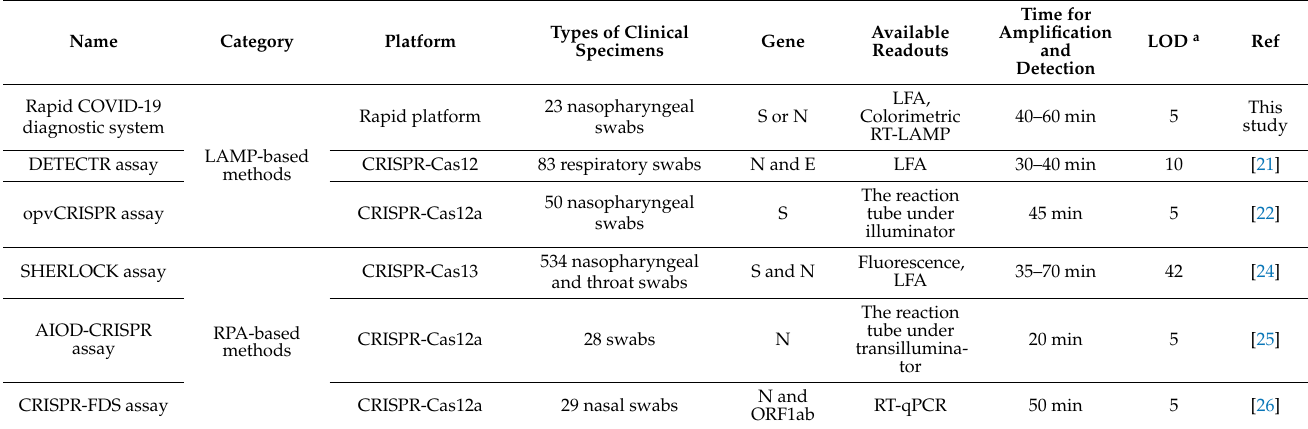
Table 1. Comparison among different isothermal amplification technologies for SARS-CoV-2 detection of clinical